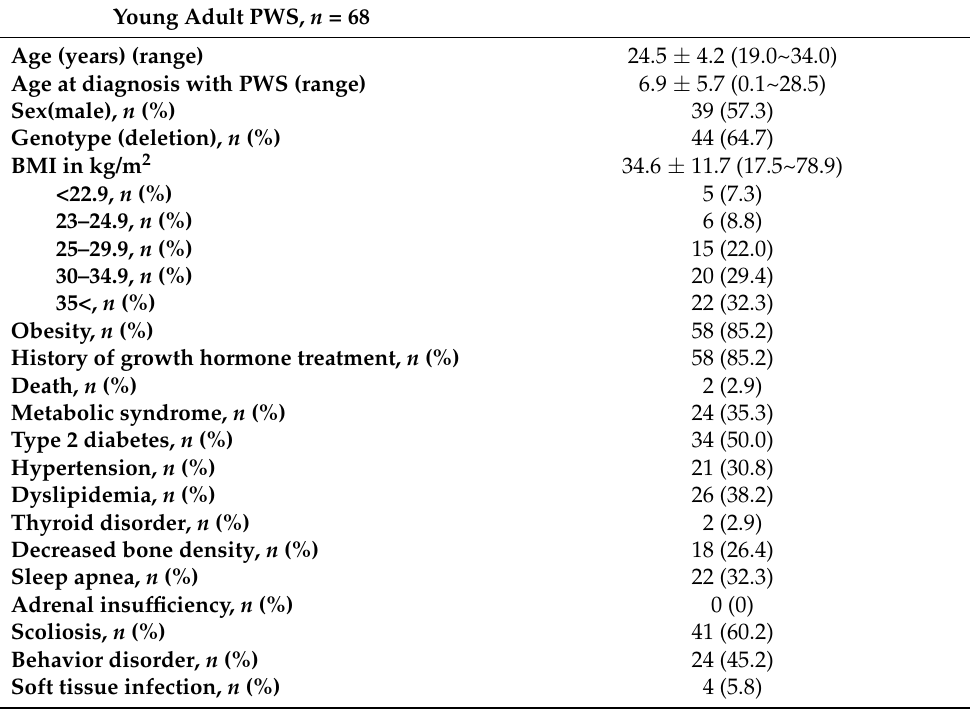
Table 1. Demographic and clinical characteristics of 68 young adults with Prader–Willi syndrome.